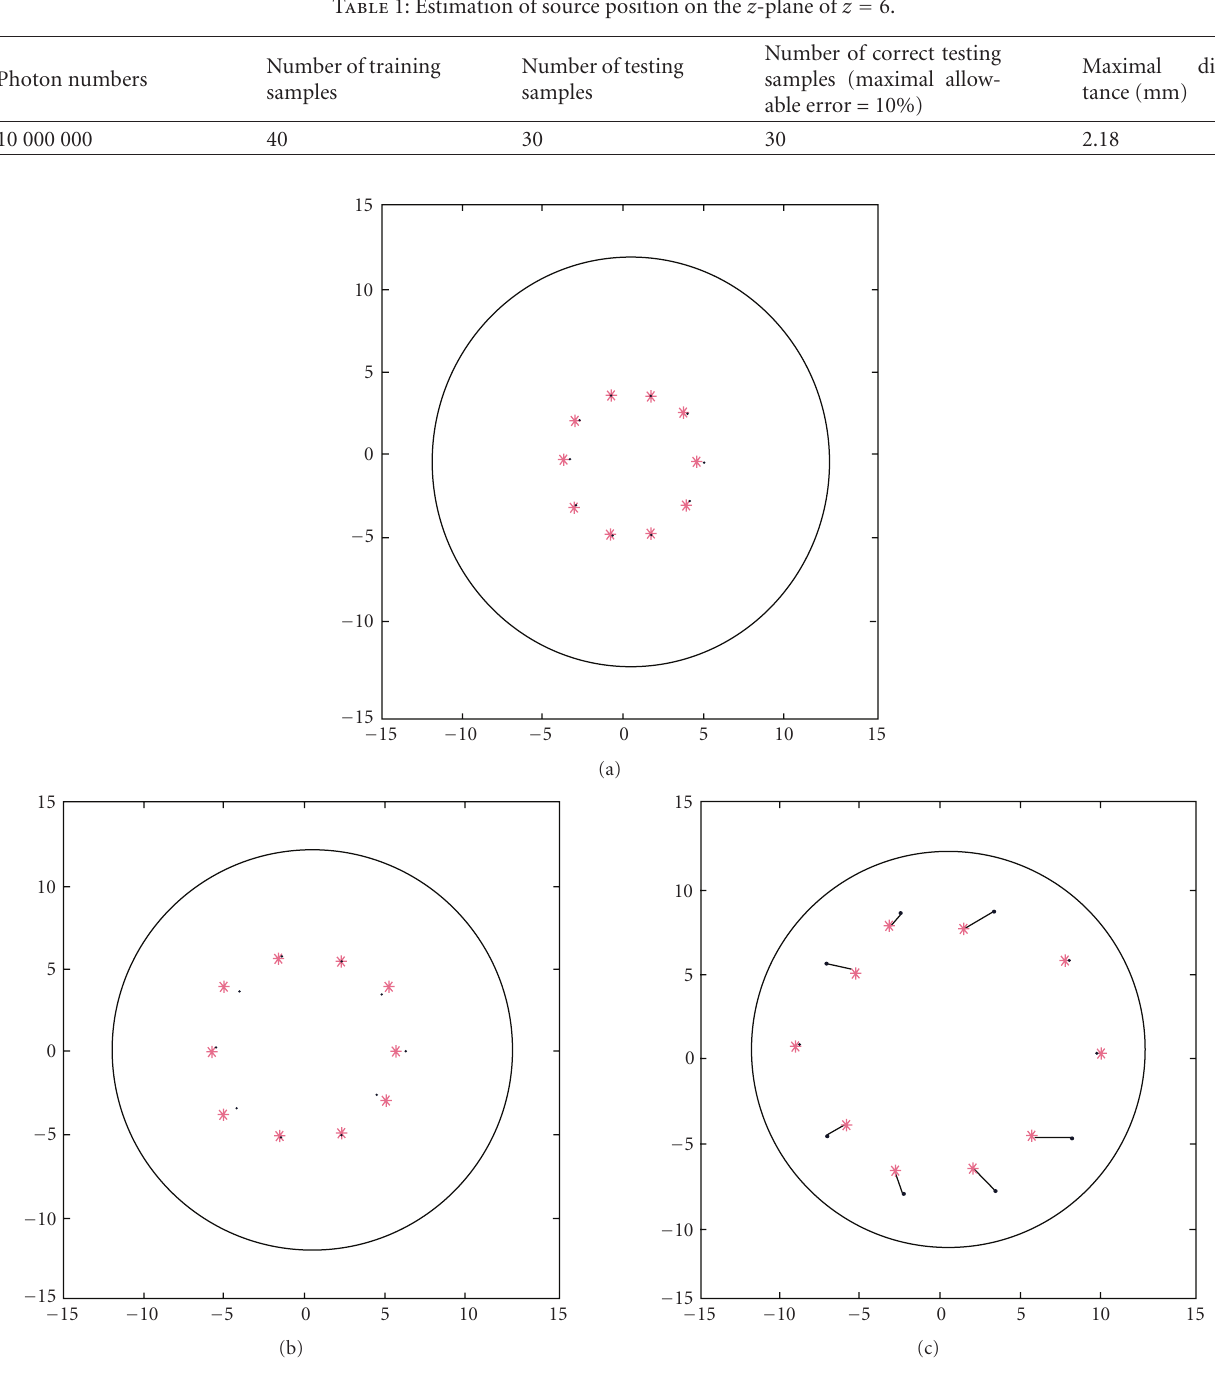
Figure 3: The comparison results between the estimated points and the actual